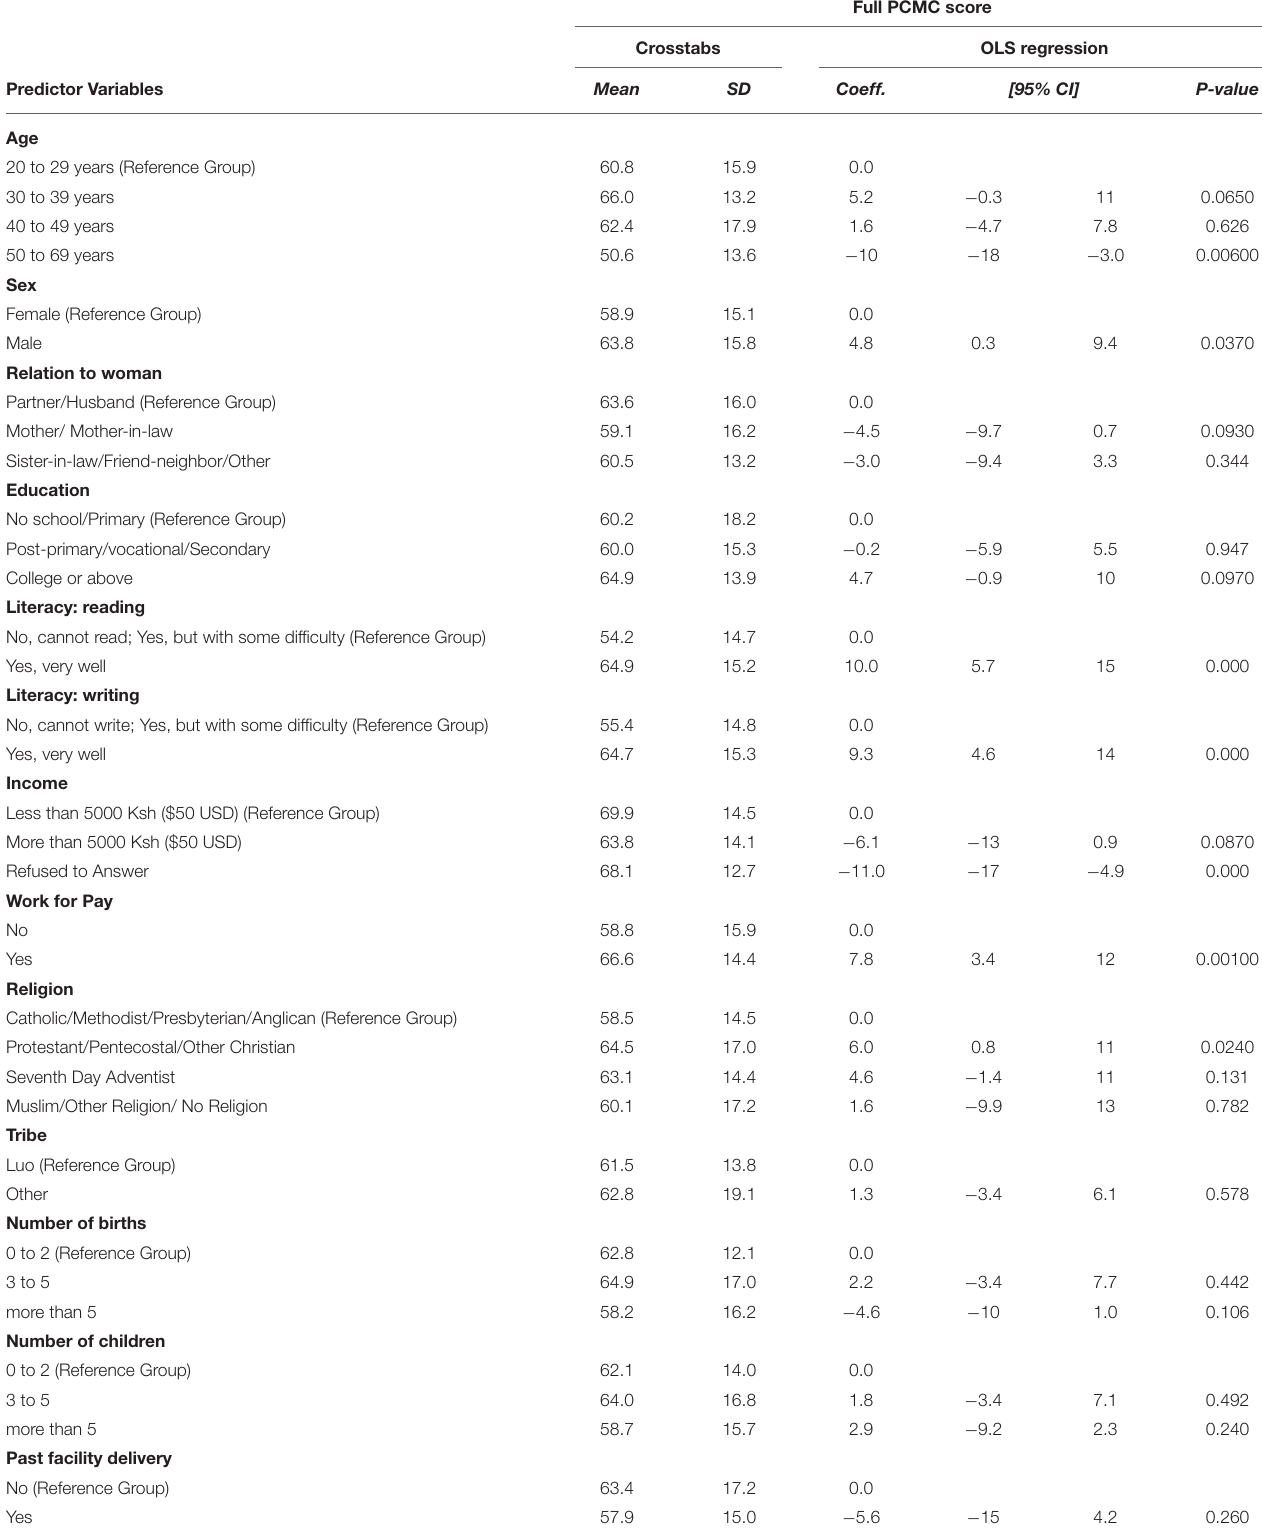
Full PCMC score Crosstabs OLS regression